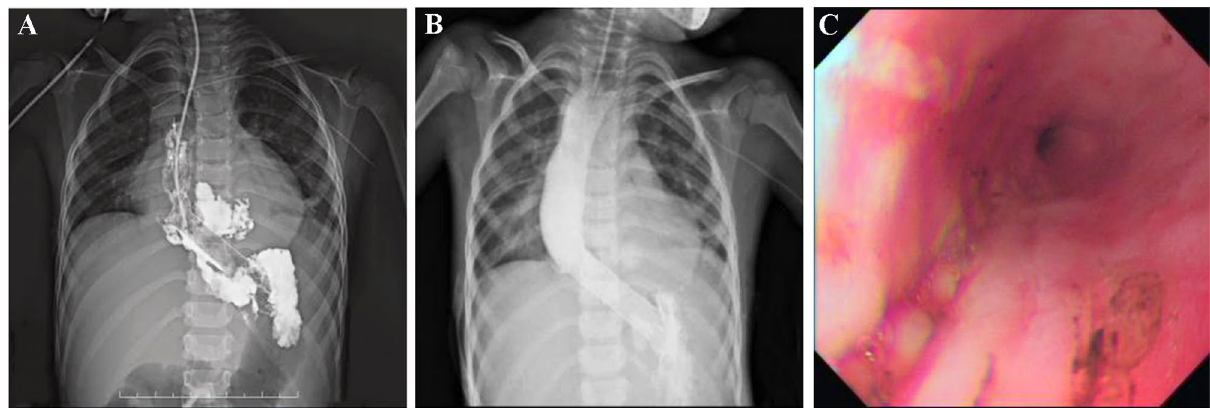
Figure 6. Stent placement in a patient with esophageal perforation after POEM (case 13). ( A ) A stent was placed after esophageal perforation was found during POEM, but stent migration occurred after 7 days; ( B ) After the stent position was adjusted under the endoscope, gastrointestinal tract radiography did not reveal extravasation of contrast medium; ( C ) The fistula was closed after the stent was removed 1.5 months